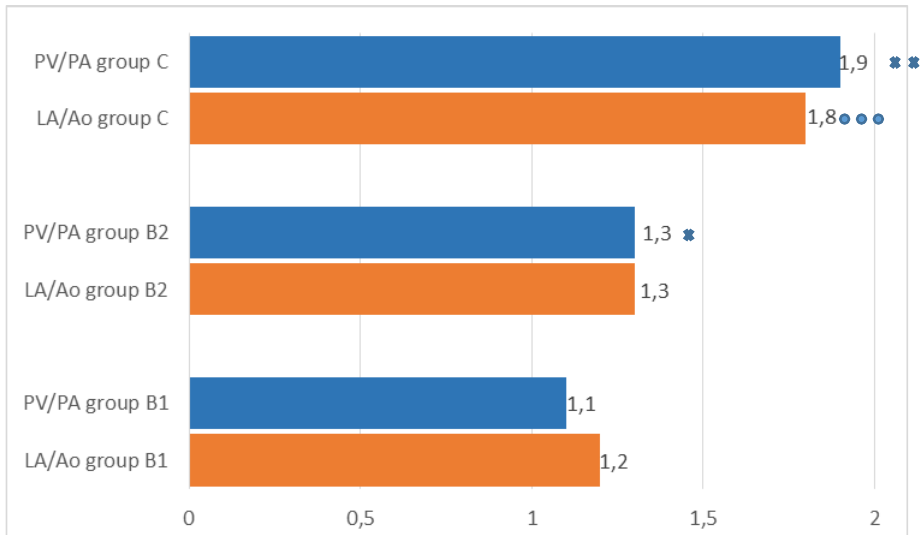
Figure 6. Horizontal Bar Chart of LA/Ao and PV/PA ratios in the development of MMVD with the indication of average values. – P < 0.05 – significant difference compared to the parameters of group B1, – P < 0.001 – significant difference compared to the parameters of group B2, – P < 0.001 – significant difference compared to the parameters of group